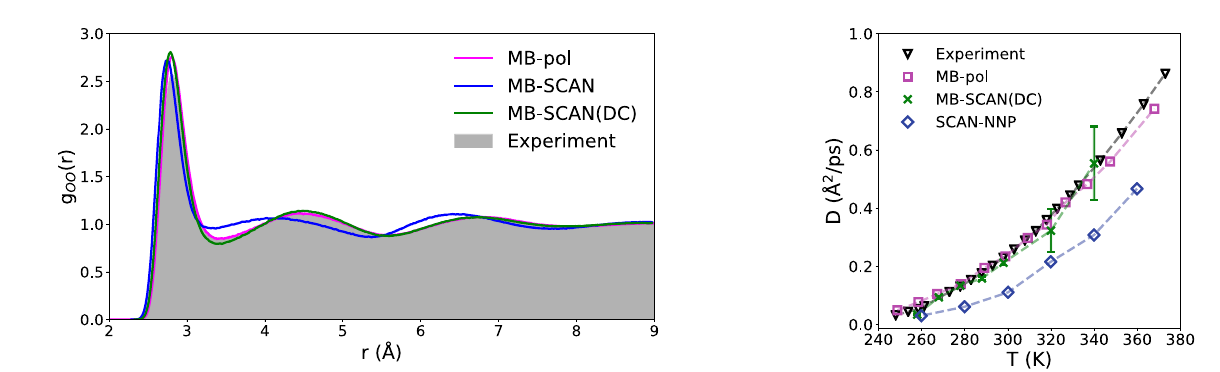
Fig. 7 Self-diffusion of liquid water. Temperature-dependence of the self- diffusion coef fi cient of liquid water calculated from NVE simulations carried out with the MB-SCAN(DC) PEF. The SCAN-NNP data are from ref. 93 , the MB-pol results are from ref. 78 , while the experimental data are from refs. 125,126,127 . Error bars for the MB-SCAN(DC) results represent 95% con fi dence intervals.